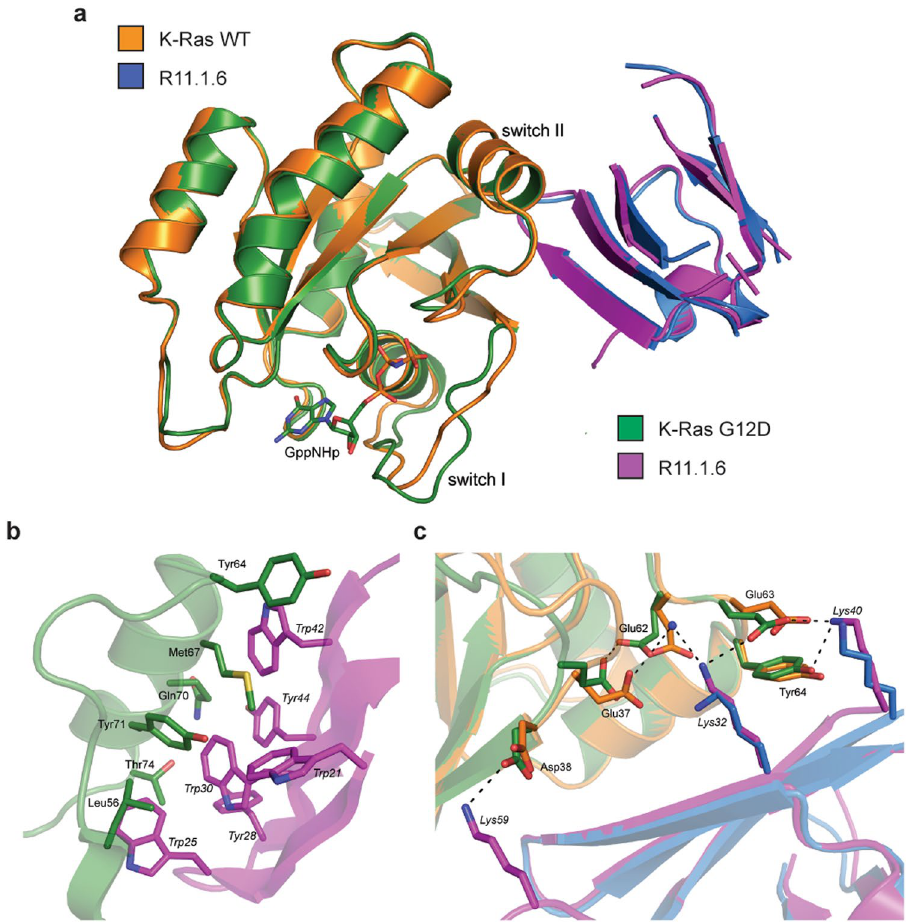
Figure 2. Switch I conformation gives rise to R11.1.6 mutant-specific binding. ( a ) Overlay of co-crystal structures of R11.1.6 with GppNHp-bound K-Ras WT and G12D. The C-terminus of R11.1.6 in both structures is partially disordered. ( b ) Binding interface between R11.1.6 (magenta) and K-Ras G12D (green) at switch II, highlighting the hydrophobic pocket created upon complex formation. K-Ras G12D residues are indicated in regular font; R11.1.6 residues are shown in italics. ( c ) Interactions between R11.1.6 lysine residues and K-Ras that give rise to greater affinity for the G12D mutant over WT. Bond distances of less than 4.0 Å are shown in dashed lines. A water molecule is shown as a blue